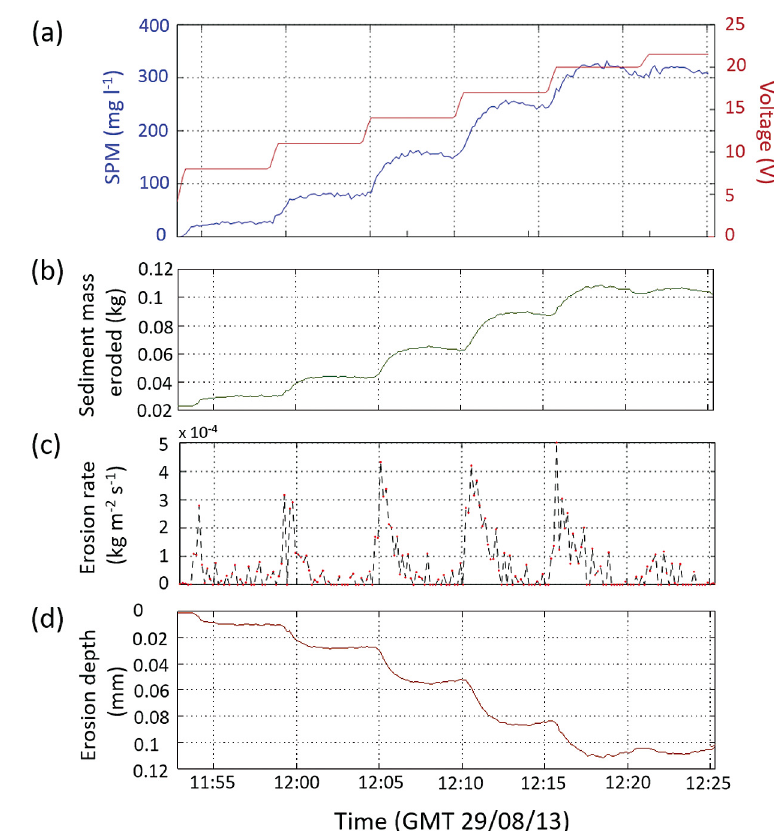
Fig. 5. Durmyon Bay 1_DUB3 (far-field) on 29 August 2013. (a) Applied voltage and total suspended solids concentration; (b) mass of suspended sediment eroded; (c) instantaneous erosion rates (computed every 20 s), indicating Type 1 erosion; (d) depth of erosion. SPM: suspended particulate